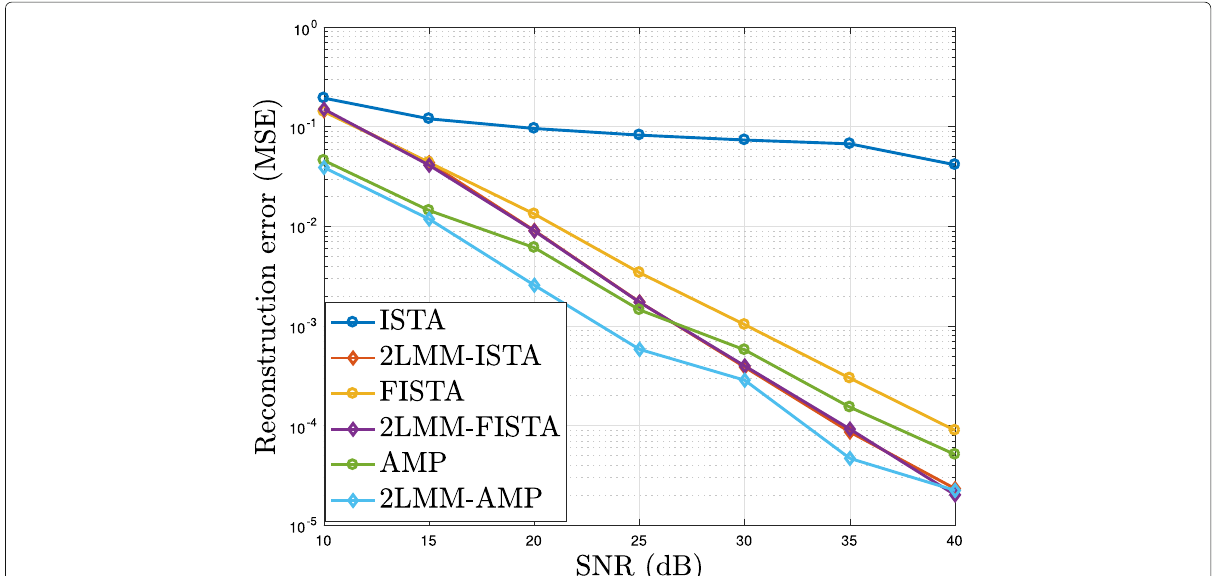
Fig. 11 Analysis of robustness against noise: the mean square error is depicted as a function of the